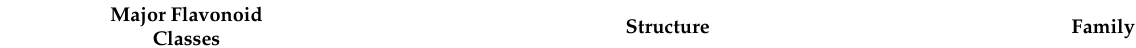
Table 1. Bioactive compounds of red-colored food and their dietary